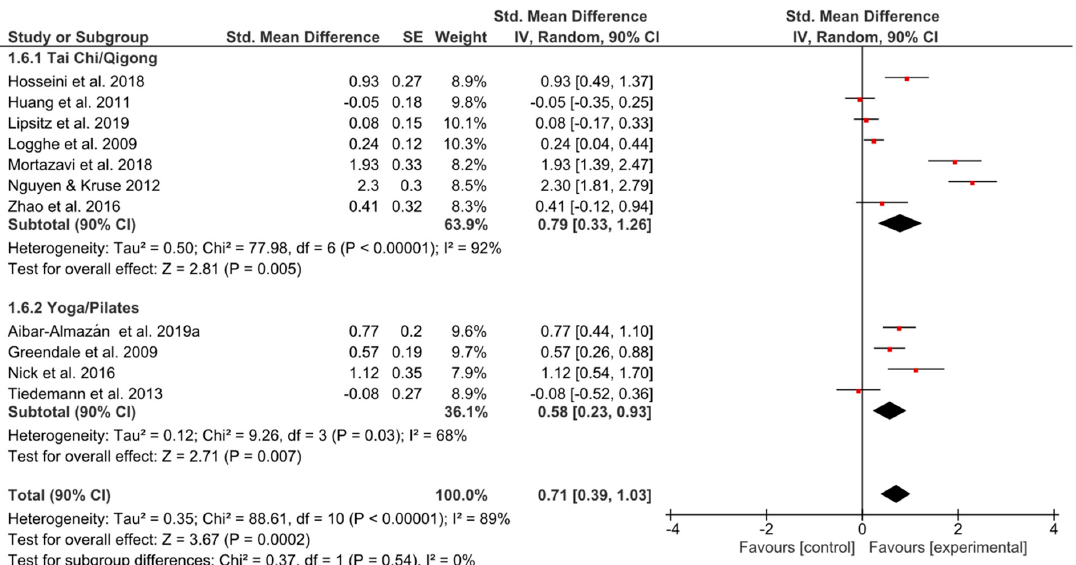
Figure 7. Standardized mean effects of mind–body interventions on fear of falling compared to a non-exercise control group. Data are separately presented for Tai Chi/Qigong and Yoga/Pilates. SE: standard error; IV: inverse variance model; CI: confidence interval; Std.: standardized.